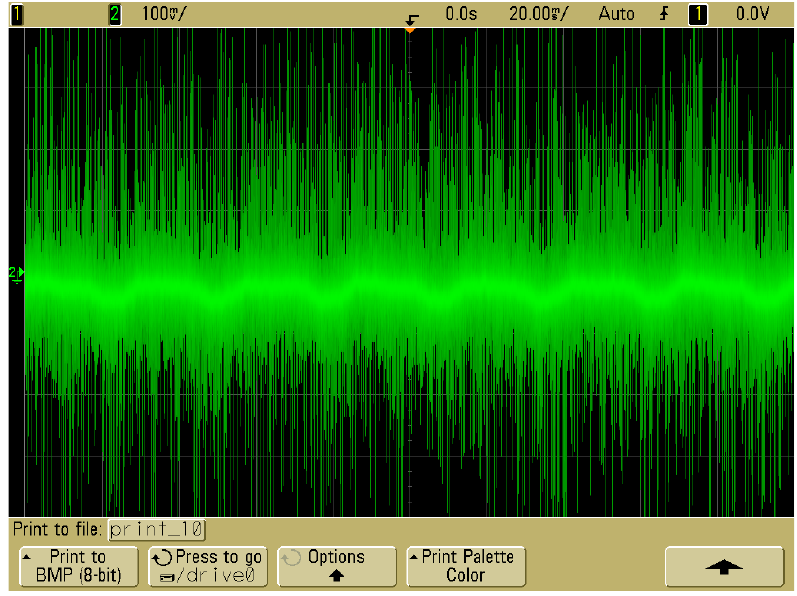
Figure 9. Voltage signal from the CASR 25-NP at 700 rpm.